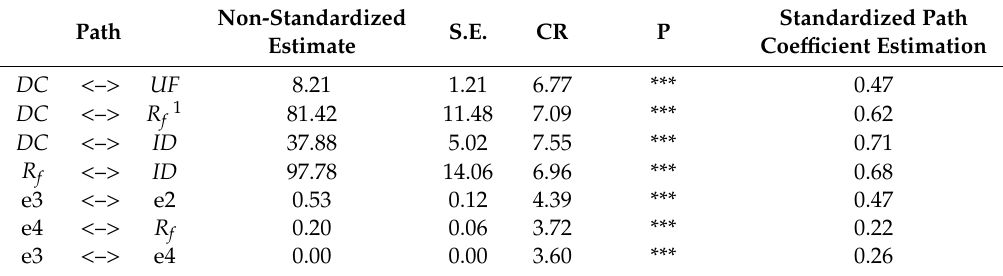
Table 5. Covariances results of SEM variables.